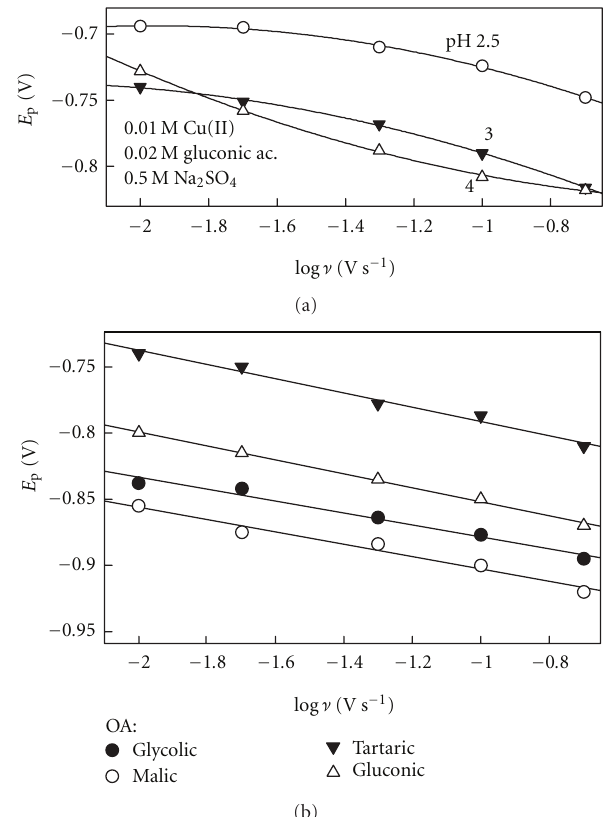
Figure 10: Dependencies of peak potentials on potential sweep rate presented in semilogarithmic coordinates. The data are obtained for 0.02M gluconic acid solutions containing Cu(II) (a) and for Cu(II)- free solutions (b), the composition of which is given in the Table